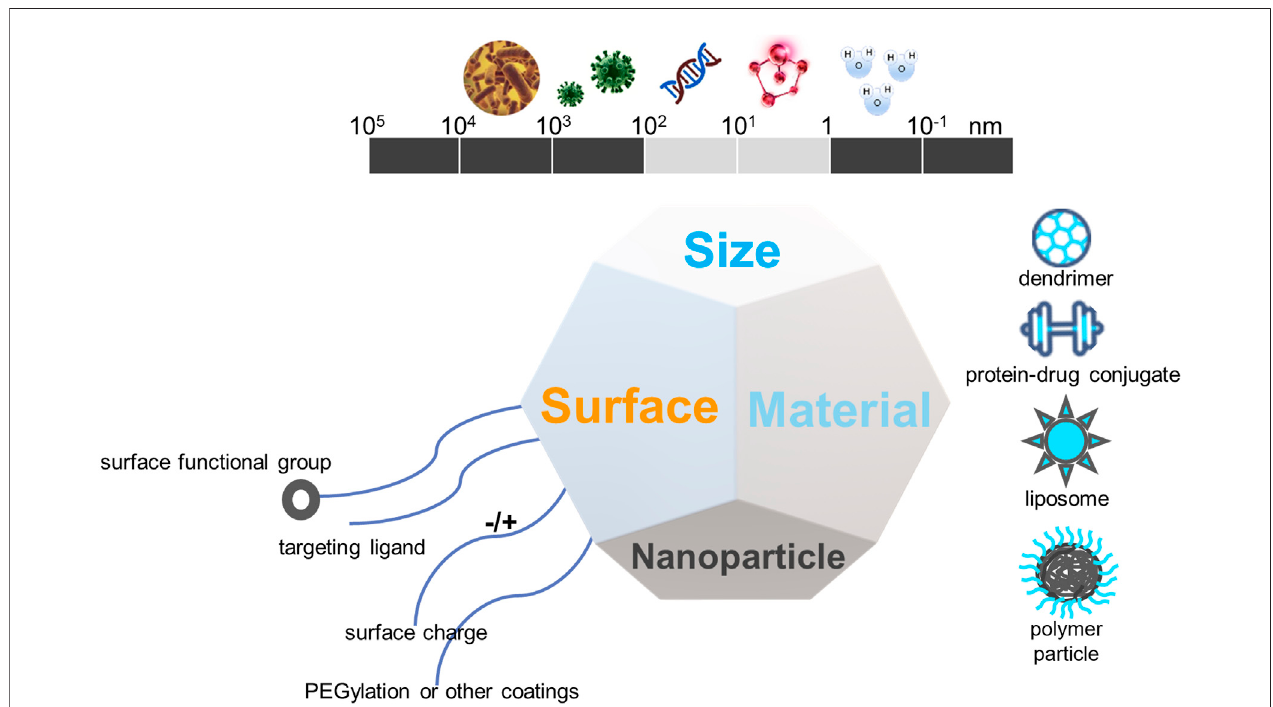
FIGURE 4 | The biophysiochemical properties of nanomaterials for drug delivery in placental dysfunction.